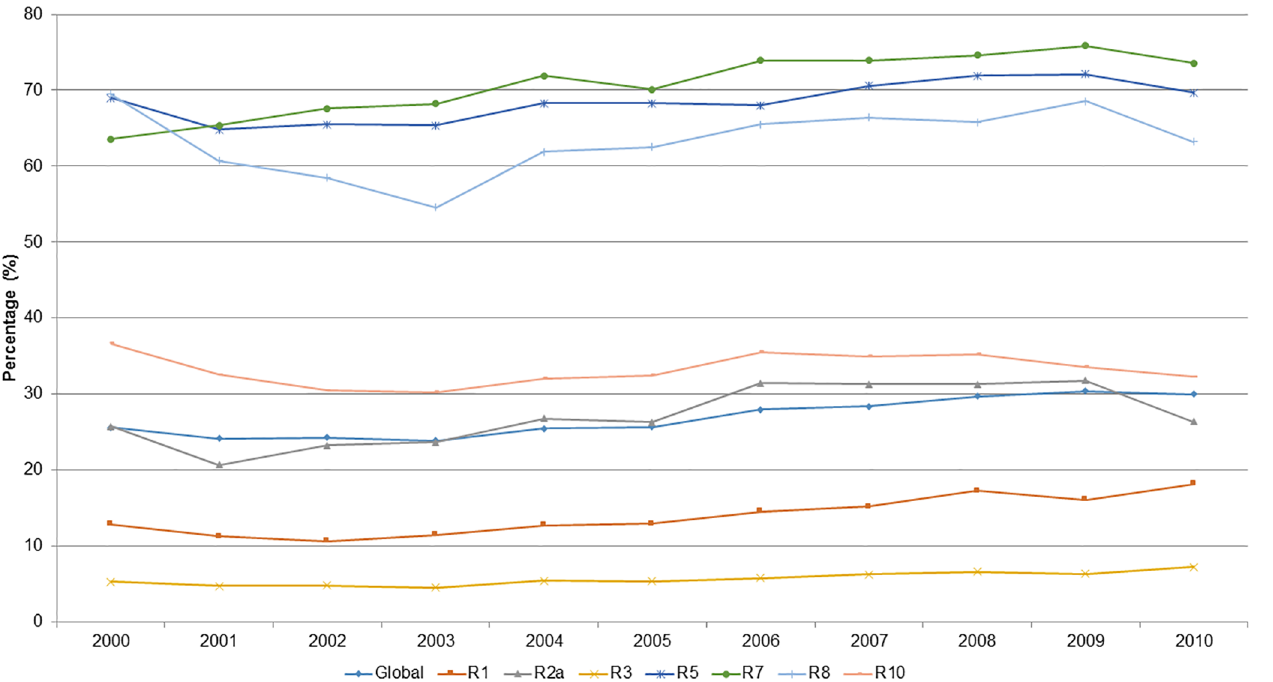
Fig 2. Evolution in cesarean sections (CS) rates in those groups of classifications of Robson with trend test p < 0.01, between the years 2000 and 2010, in public hospital of